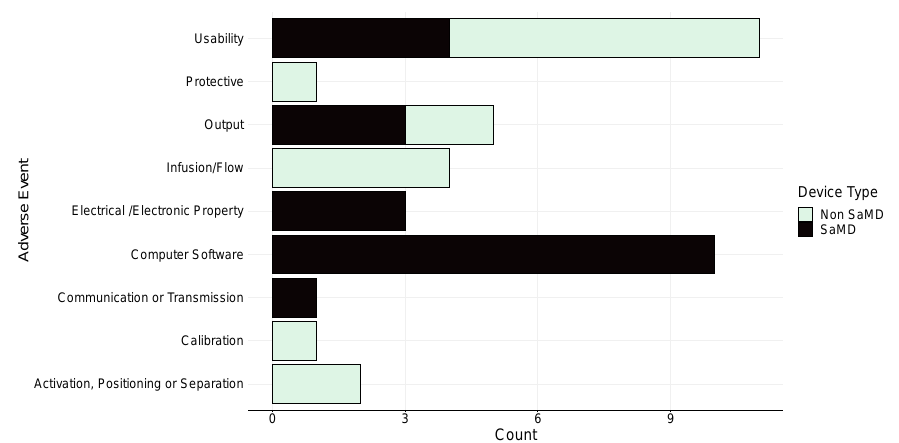
Figure 5. Number and type of adverse events for both SaMD and non-SaMD software.